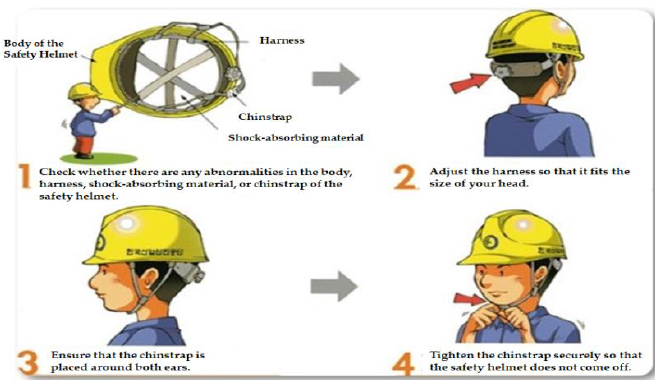
Figure 3. Occupational safety and health agency guide to wearing a safety helmet.